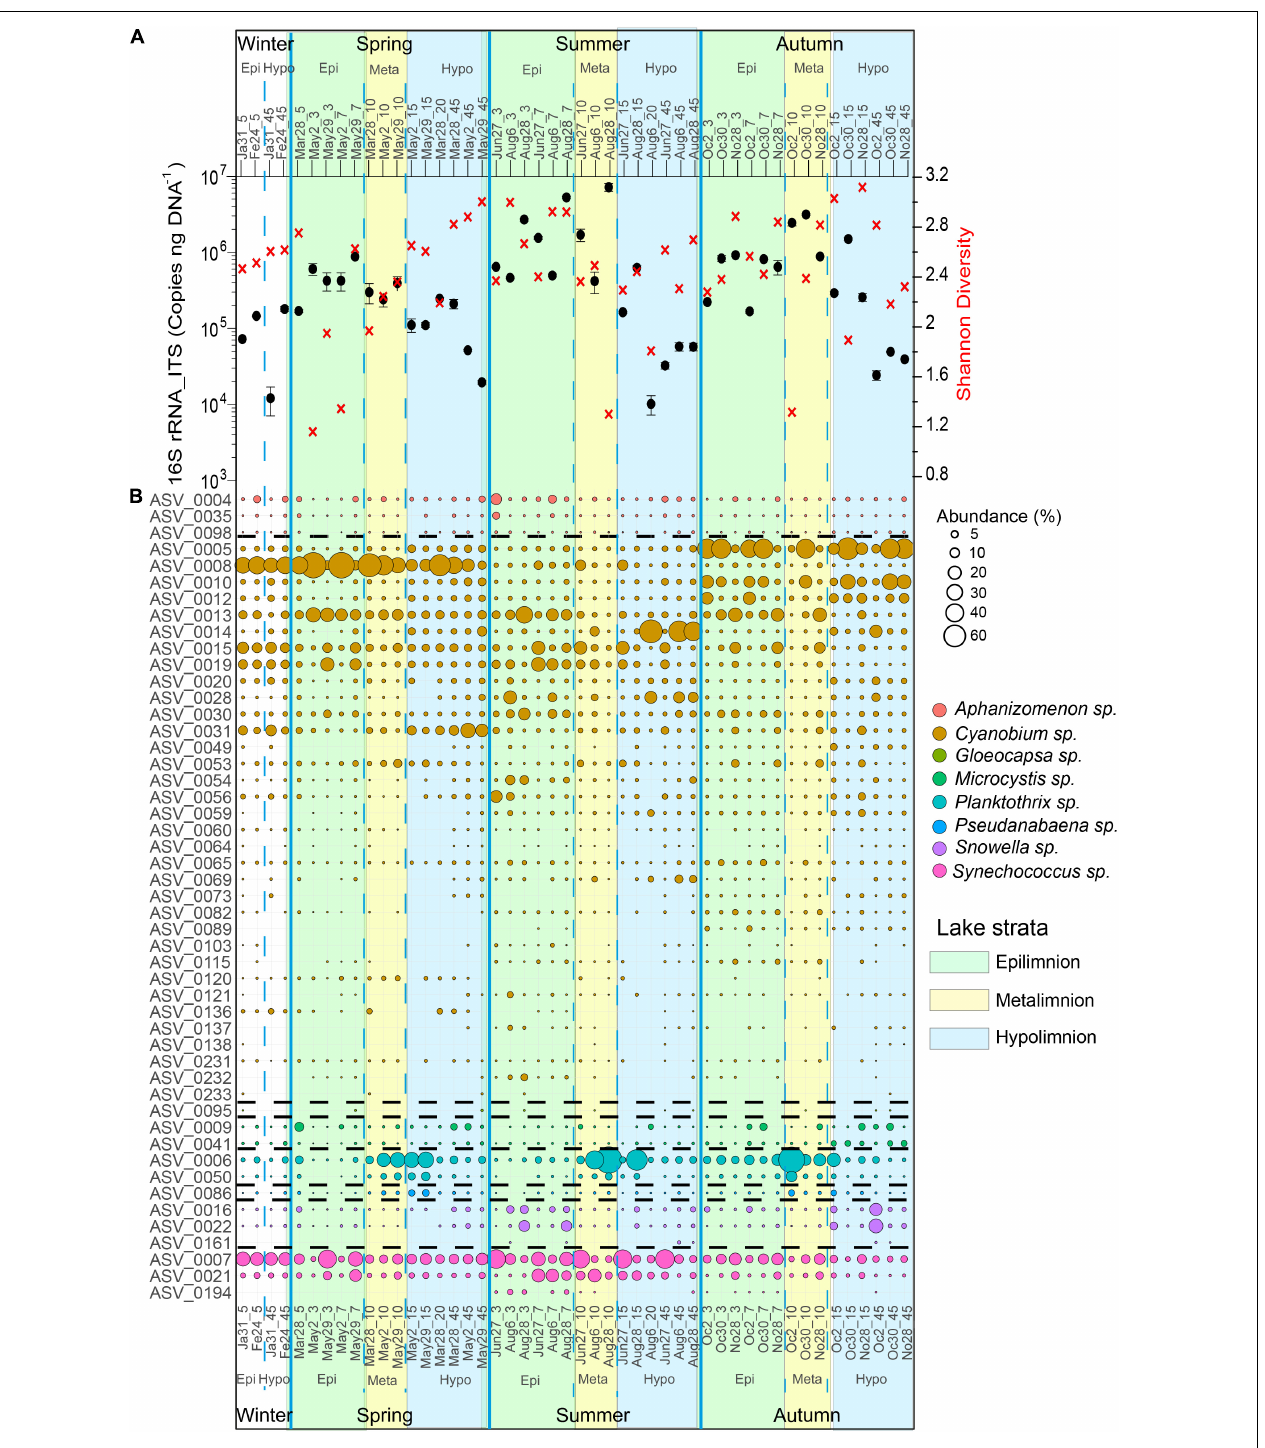
FIGURE 4 | Cyanobacteria community structure, abundance and diversity in Lake Tiefer See throughout the year 2019. (A) Cyanobacterial abundance quantified via qPCR (black dots; Error bars, which are hidden by the dots in some cases, give the standard deviations for three independent amplifications.) and Shannon diversity (red crosses). (B) Bubble plot showing the spatiotemporal variation of cyanobacteria community composition at the amplicon sequence variant level (cutoff > 0.1% relative abundance). Numbers beside months refer to sampling date while number after the underscore refers to water depth, e.g., May2_10 refers to a sample collected at 10 m water depth on 2nd May. Epi = epilimnion, Meta = metalimnion, Hypo = hypolimnion. Taxa follow the same order as in the legend and broken lines indicates where the bubbles of one taxon end and the next begins.